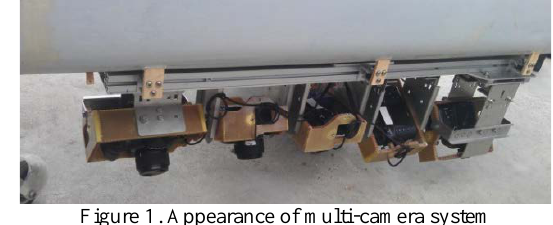
Figure 1. Appearance of multi-camera system